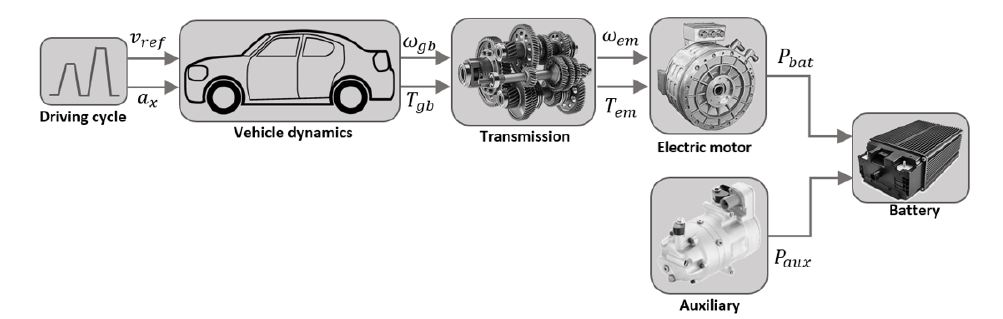
Figure 1. BEV model data flow for energy consumption computation.